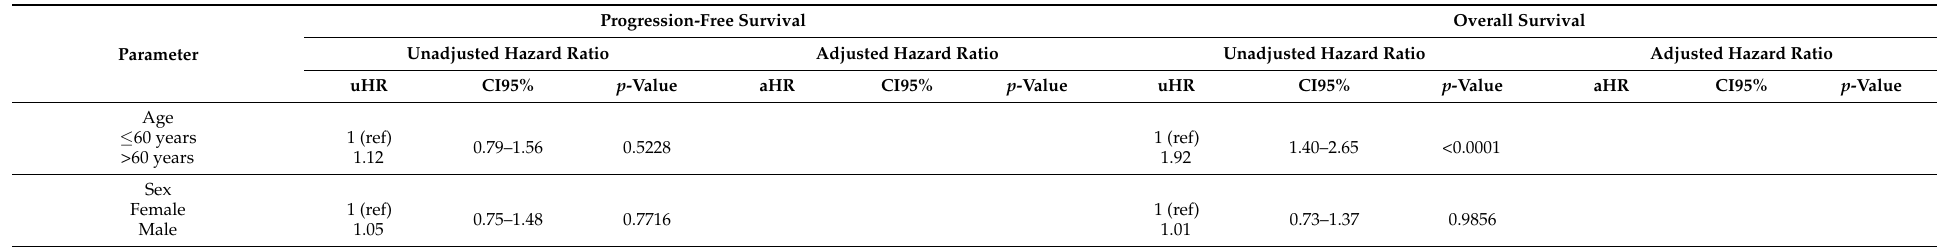
Table 4. Univariate and multivariate predictors of progression-free survival and overall survival in the subgroup of patients operated on by neurosurgeon expert both in awake and asleep surgery ( n = 223). Unadjusted hazard ratios by logrank tests and adjusted hazard ratios by Cox proportional hazards